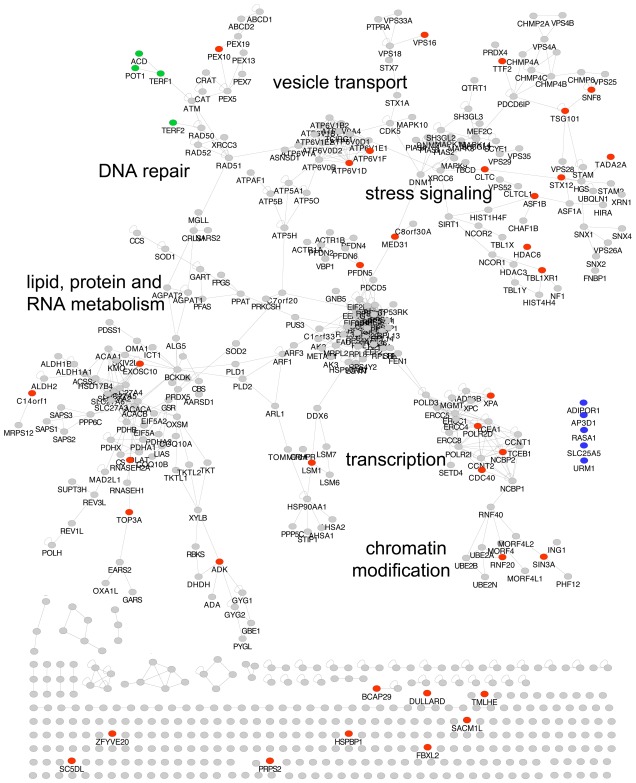
Human interaction network shows high connectivity among putative human toxicity-modulating proteins homologous to toxicity-modulating proteins in yeast.The largest connected component of the human interactome selected from yeast orthologs being required for damage recovery after treatment with MMS, 4NQO, t-BuOOH and UV [13]. The circles represent: red – proteins with toxicity-modulating yeast homologs targeted for silencing in this study; grey – proteins with toxicity-modulating yeast homologs not targeted in this study; blue – proteins with non-toxicity-modulating yeast homologs targeted in this study; green –proteins specific for mammalian telomere maintenance targeted in this study. An interactive version of this figure is available at http://www.bionut.ki.se/users/pesv/MIT/fig1.html.